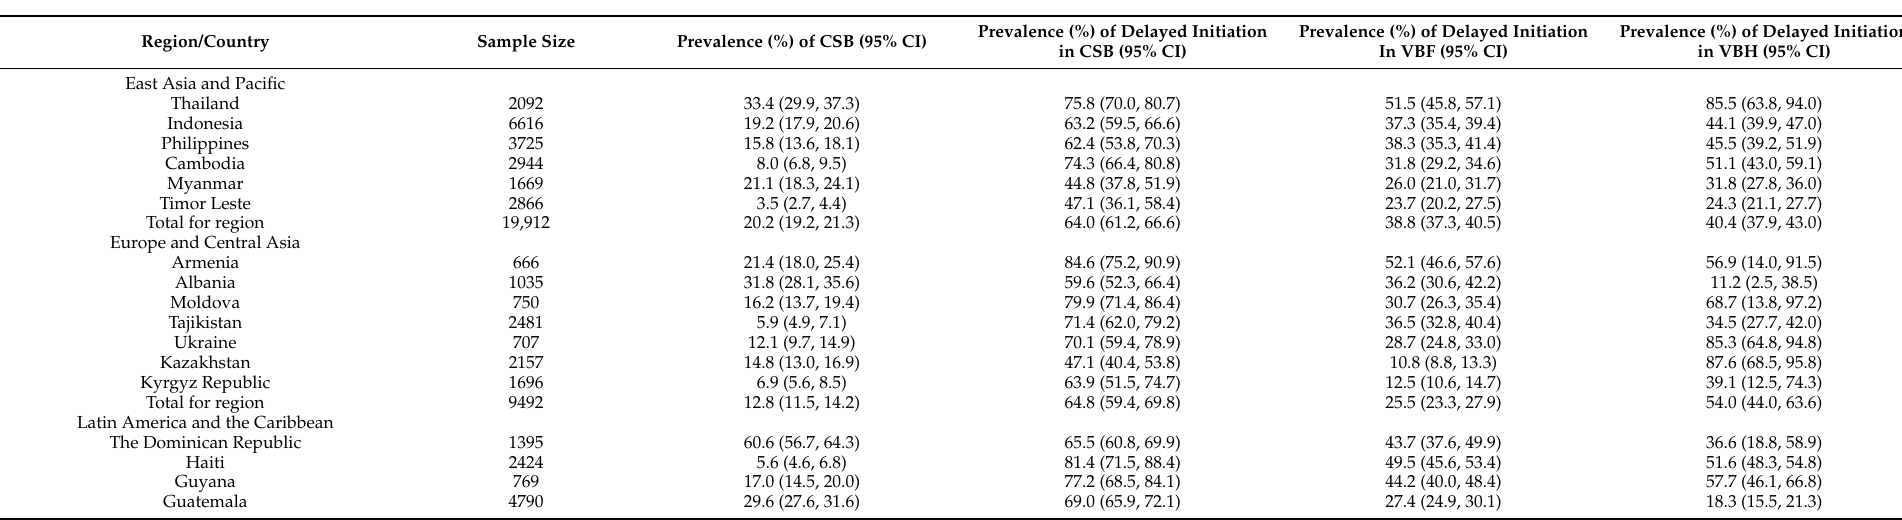
Table 2. Prevalence of delayed initiation of breastfeeding among caesarean section births (CSB), vaginal births at home (VBH) and vaginal births at a health facility